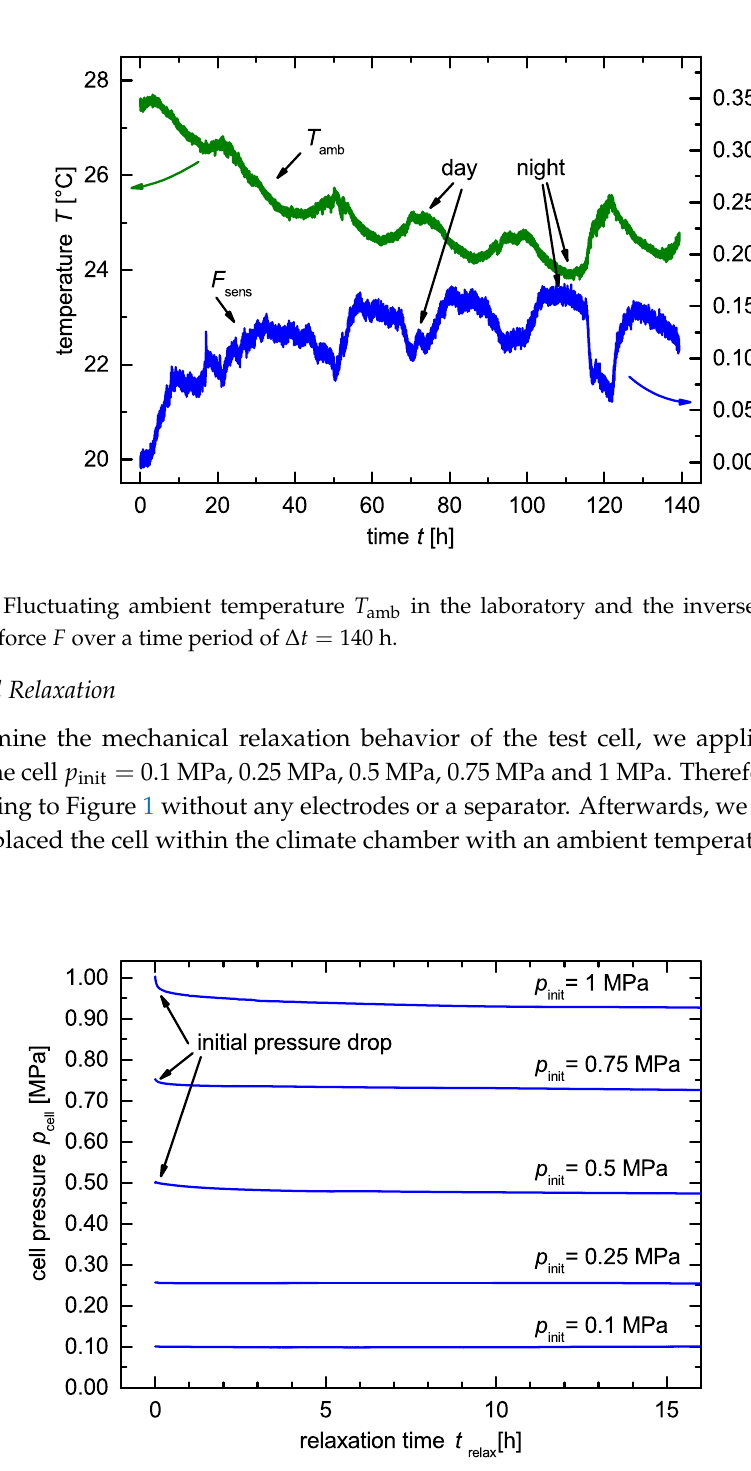
Figure 4. Mechanical relaxation of the pressure monitoring cell for p init = 0.1 MPa, 0.25 MPa, 0.5 MPa, 0.75 MPa and 1 MPa. An increasing initial pressure leads to an increasing relaxation time t relax and a higher initial pressure